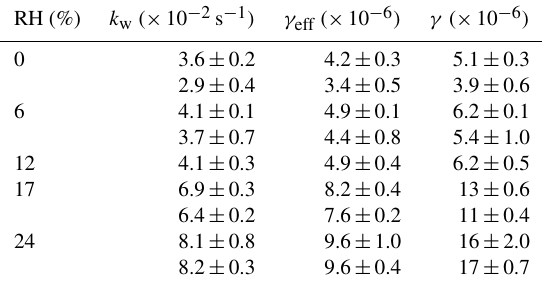
Figure 3. Decays of ClONO 2 in the flow tube due to its loss onto the Pyrex glass (circles: 0%RH; squares: 24%RH). Measured ClONO 2 mixing ratios were normalised to that at 8.5s (when the in- jector was at 30cm). Typical ClONO 2 mixing ratios in the flow tube are a few hundred parts per billion by volume (ppbv; see Fig. 2).